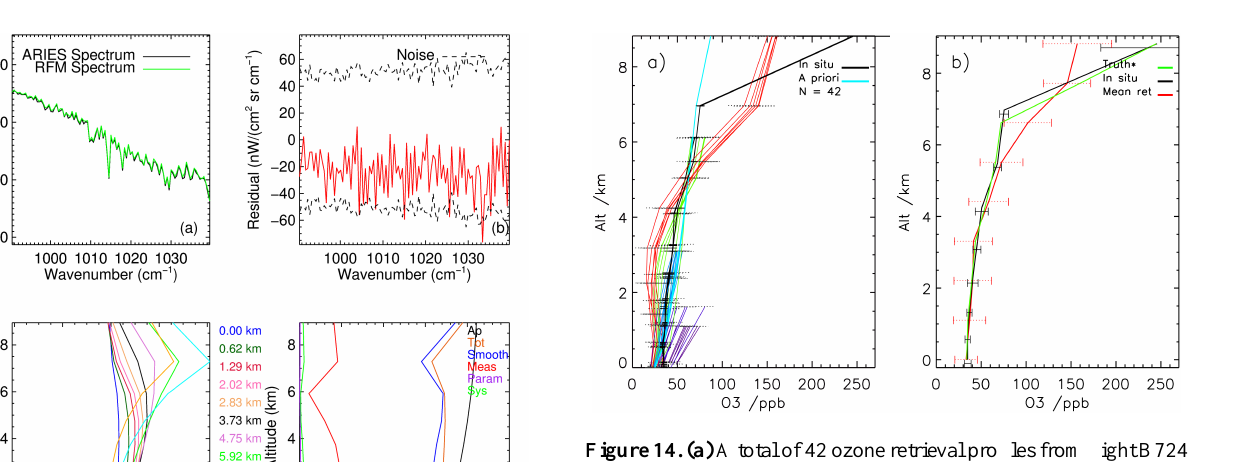
Figure 14. (a) A total of 42 ozone retrieval profiles from flight B724 colour coded for flight altitude. Retrieval uncertainty (total error) is shown as the dotted bars in each case. In situ and a priori profiles are also shown as per legend. (b) Mean profiles from flight B724 for retrieved (red), in situ measured (black), and in situ data aver- age convolved with ARIES averaging kernels (green). The in situ 1 σ measurement variability is shown as black bars at each binned vertical level and the root mean square retrieval uncertainty (total error) is shown by the red bars.